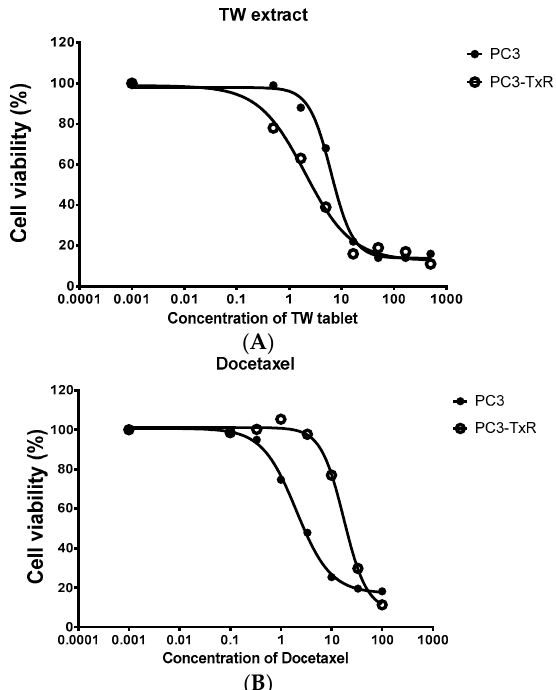
Figure 2. Cell viability (measured from triplicate samples) of a prostate cancer cell line (PC3) and its Dtx resistant cell line (PC3-TxR) treated with the extract of Tripterygium wilfordii (TW) extract. ( A ) The cytotoxicity of TW tablets on PC3-TxR was much more potent than PC3 (IC 50 of 1.9 vs. 6.3 μ g/mL for PC3-TxR and PC3 respectively); ( B ) PC3-TxR showed resistance to TRAIL (IC 50 of 28.2 vs. 3.4 ng/mL for PC3-TxR and PC3 respectively).